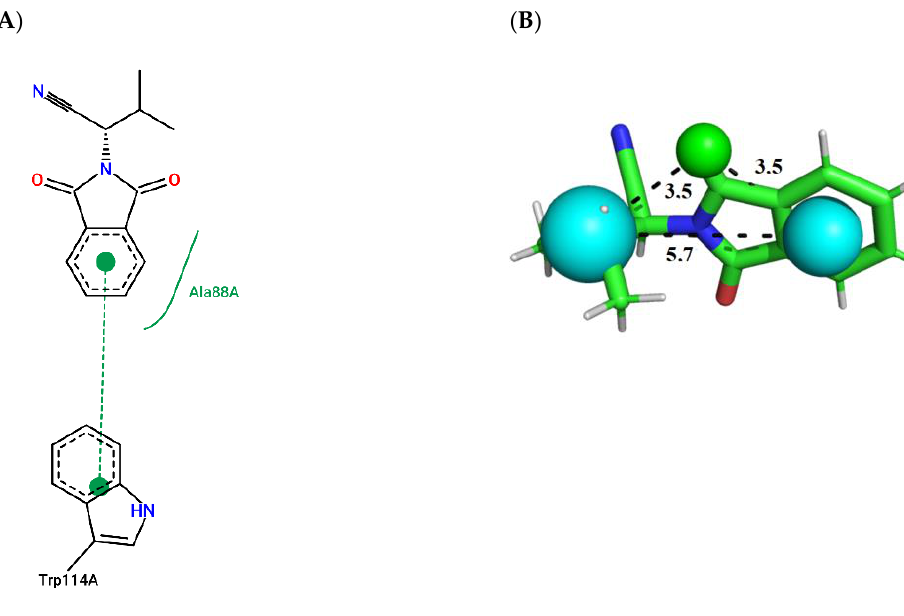
Figure 5. ( A ) Interaction map of ZINC878 in the PoseView software generated by the Aaeg OBP1 binding site (ChemPLP = 56.59). ( B ) ZINC878 superimposed on the model pharmacophore Aaeg OBP1 (QFIT = 83.86). Cyan spheres represent hydrophobic centers (HY) and green spheres represent hydrogen bond donors (HBD). The size of the spheres varies according to the radius tolerance calculated by GALAHAD™. All distances were measured in angstroms. (Legend: Ligand: Carbons are represented in green, nitrogen in blue and oxygen in red).